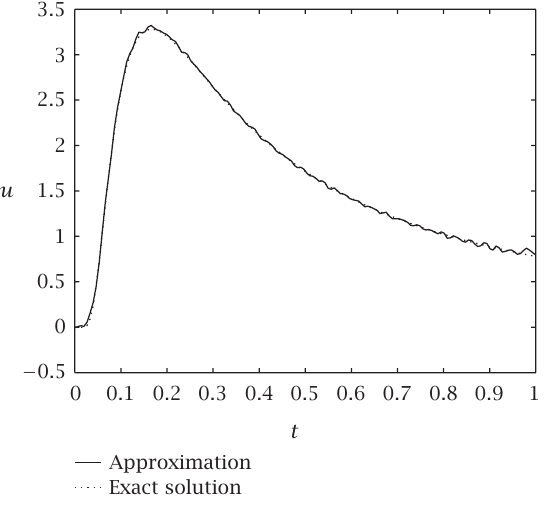
Figure 3.2. x = 0, p = 1, δ = 10 − 5 , E = 12, k = 1 /